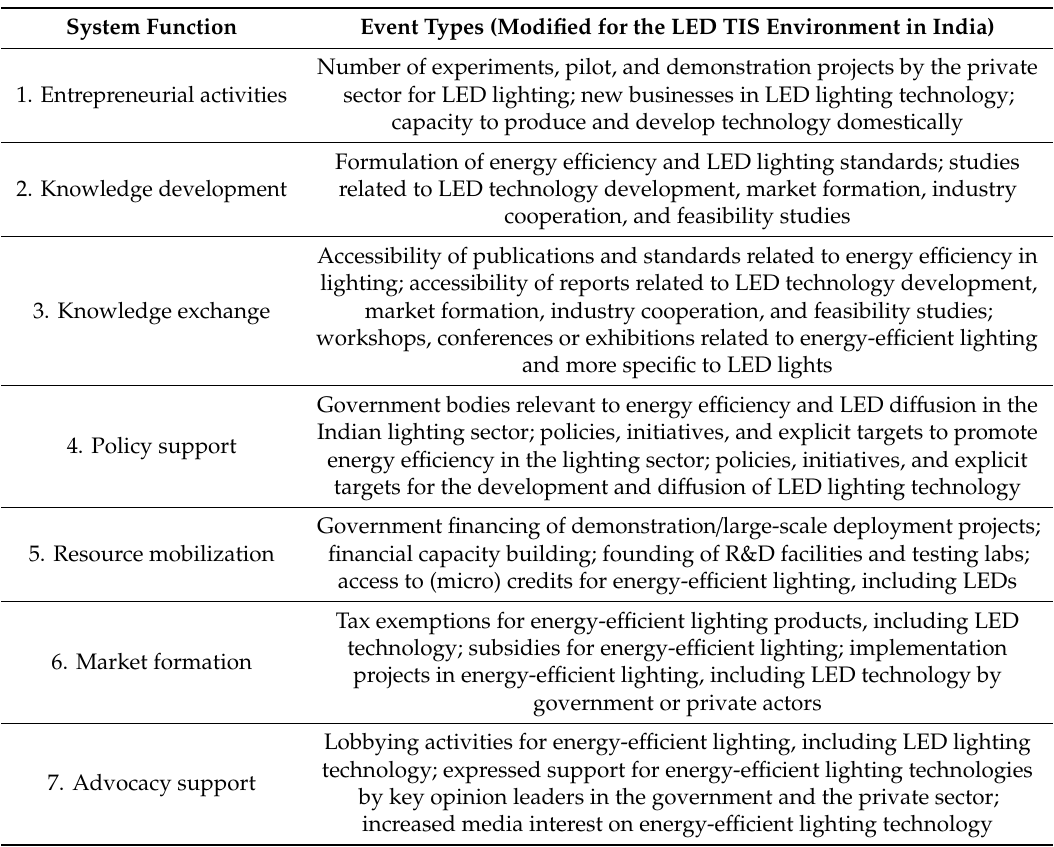
Table 1. Event types associated with the functions of innovation systems in the Indian LED sector. Source: modified after